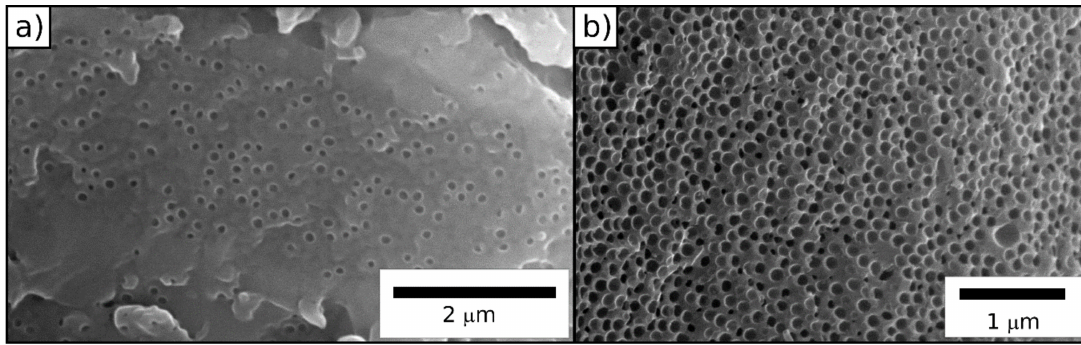
Figure 12. SEM photographs of the ( a ) surface and ( b ) cross-section of a porous SiCN film after melt-shearing and ceramization of core / shell particles processed by emulsion polymerization and